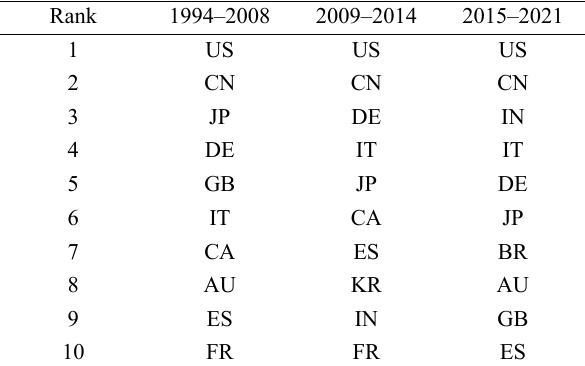
Table 5 Top 10 countries (number of publications) in different time